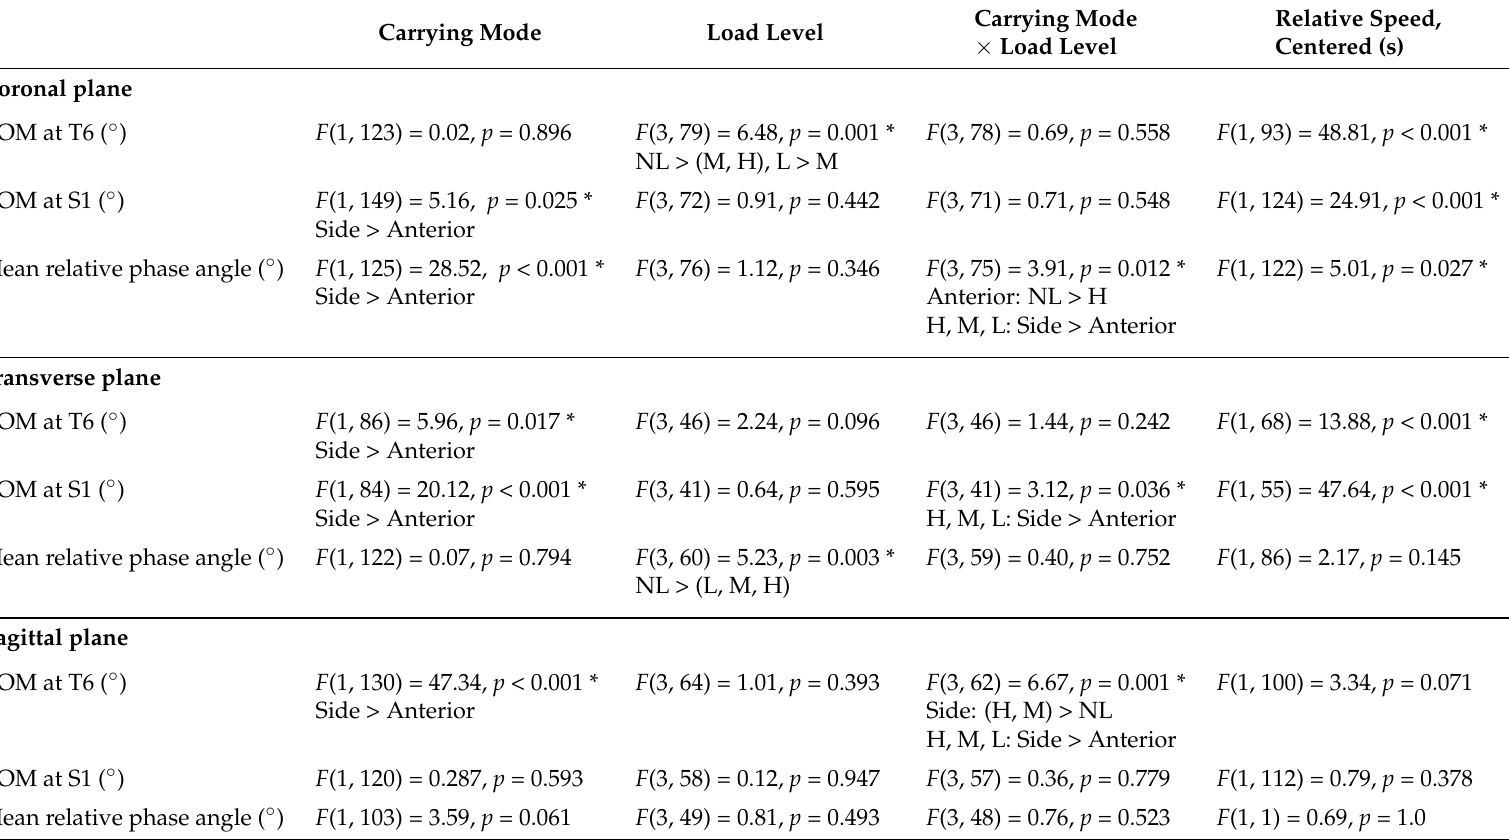
Table 4. Experiment-2 ( n = 10) summary results from the mixed effects analyses for the main and interaction effects of carrying mode and load level on torso and pelvis sway and thoracic-pelvic coordination in the coronal, transverse, and sagittal planes. Significant pairwise Bonferroni comparisons ( p < 0.05) are provided for main and interaction effects that were significant at p < 0.05 indicated by *. NL = No-load (empty-handed), L = Low load at 4.5 kg, M = Medium load at 9.1 kg, H = High load at 13.6